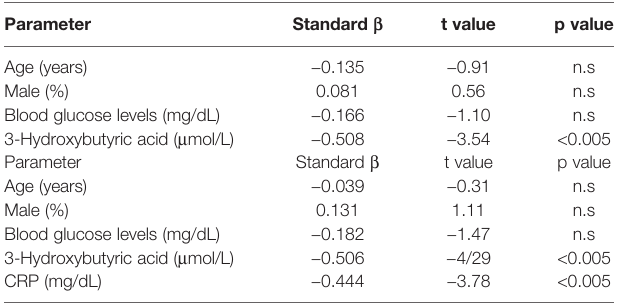
TABLE 3 | Multiple regression analysis about several factors in fl uencing FT3